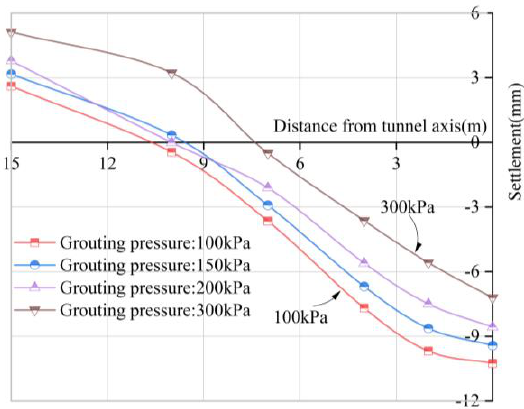
Figure 10. Influence of grouting pressure on the lateral deformation of the ground surface.